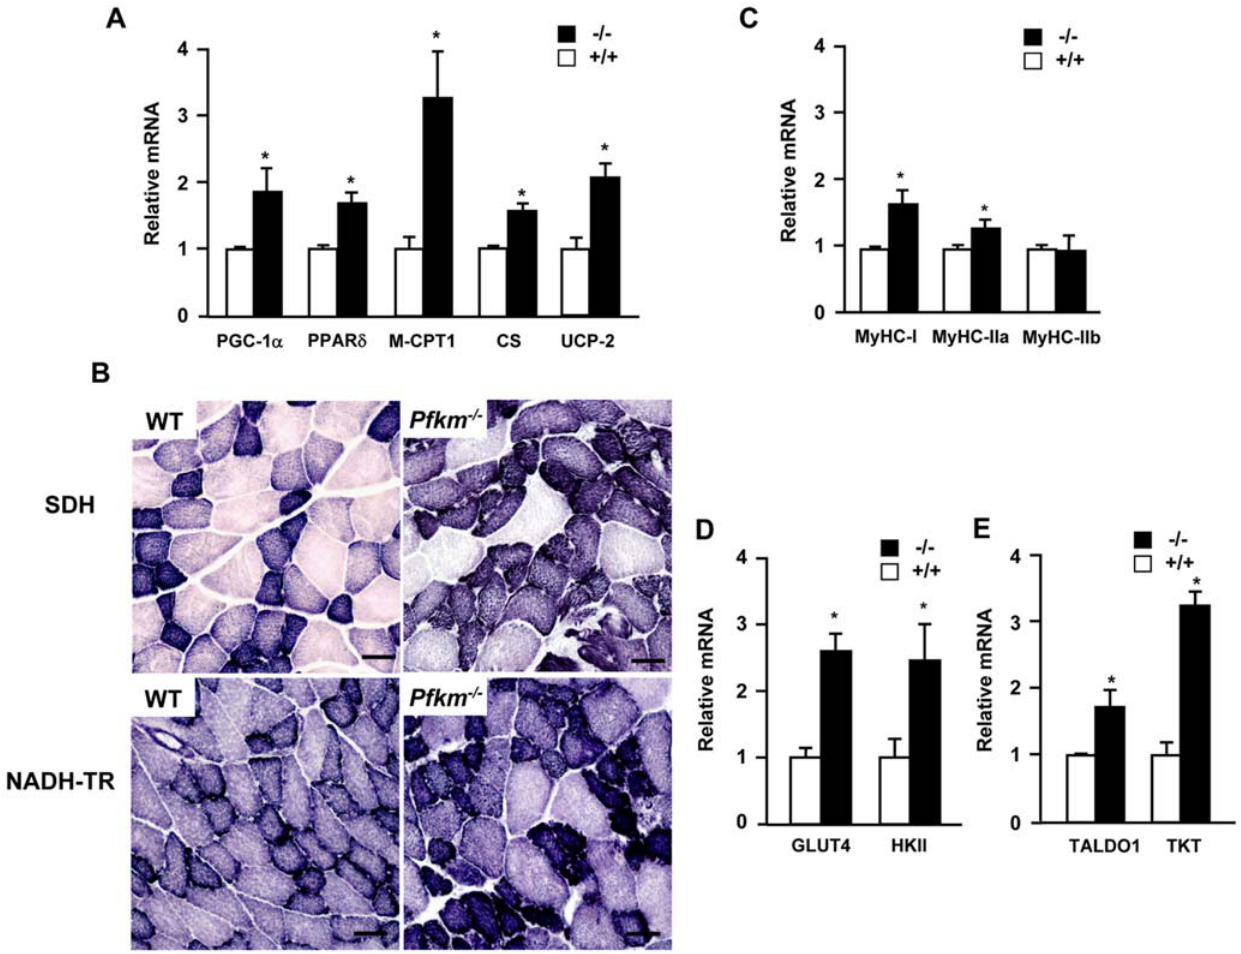
Figure 3. Effects of PFKM deficiency in skeletal muscle markers. (A) Expression of key genes in oxidative metabolism in skeletal muscle of wild-type and Pfkm 2 / 2 mice: Peroxisome proliferator-activated receptor c coactivator-1 a (PGC-1 a ), peroxisome proliferator-activated receptor d (PPAR d ), carnitine palmytoiltransferase-1 (M-CPT-1), citrate sinthase (CS) and uncoupling protein 2 (UCP-2). (B) Histochemical staining for succinate dehydrogenase (SDH) and NADH-tetrazolium reductase (NADH-TR) activities in skeletal muscle of wild-type and Pfkm 2 / 2 mice. Scale bar 25 m m. (C) Expression of myosin heavy chains in skeletal muscle of wild-type and Pfkm 2 / 2 mice: Type I, IIa ,and IIb myosin heavy chains (MyHC-I, MyHC-IIa, MyHC-IIb). (D) Expression of the key genes in skeletal muscle glucose uptake, glucose transporter 4 (GLUT4) and hexokinase-II (HKII), in wild-type and Pfkm 2 / 2 mice. (E) Expression of pentose phosphate pathway genes, transaldolase (TALDO1) and transketolase (TK), in skeletal muscle of wild-type and Pfkm 2 / 2 mice. Relative expression in A, C, D and E was determined by quantitative PCR analysis of total RNA from skeletal muscle, as indicated in Materials and Methods. Results are mean 6 SEM of five mice per group. * P , 0.05 vs. wild-type.